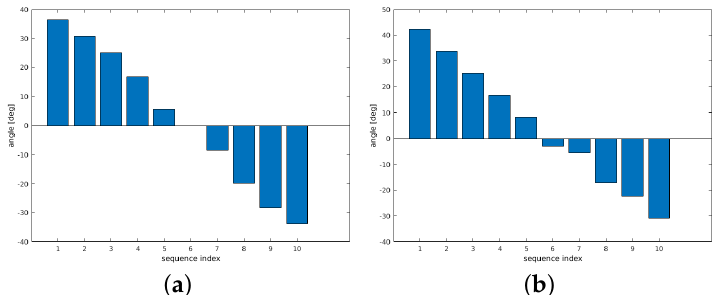
Figure 11. B1—Example for a registration across different persons, that is, a segmented bone from one person is correctly matched within the body of another person. ( a ) Registration result—center position (person 1) from hand movement within person 2. ( b ) Registration result—center position (person 1) from hand movement within person 3.